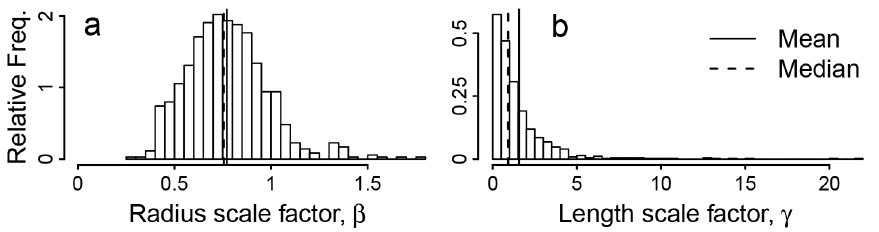
Fig 2. Ratio-Based Exponent Distribution. Plots of (a) frequency distribution of scale factor β , the ratio of child to parent radii, and (b) the analogous distribution of scale factor γ , the ratio of child to parent lengths.